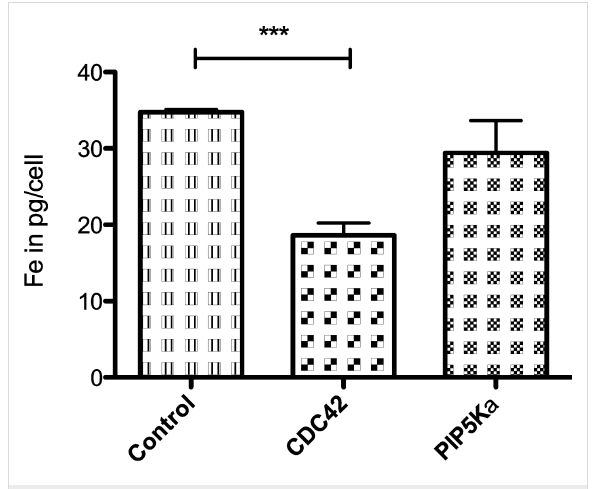
Figure 9: Iron content of control and transfected HeLa cells in pg/cell after 24 h incubation with PEGylated SPIONs; target proteins: CDC42, PIP5K α (iron concentration 50 µg/mL, error bars: SEM, n =